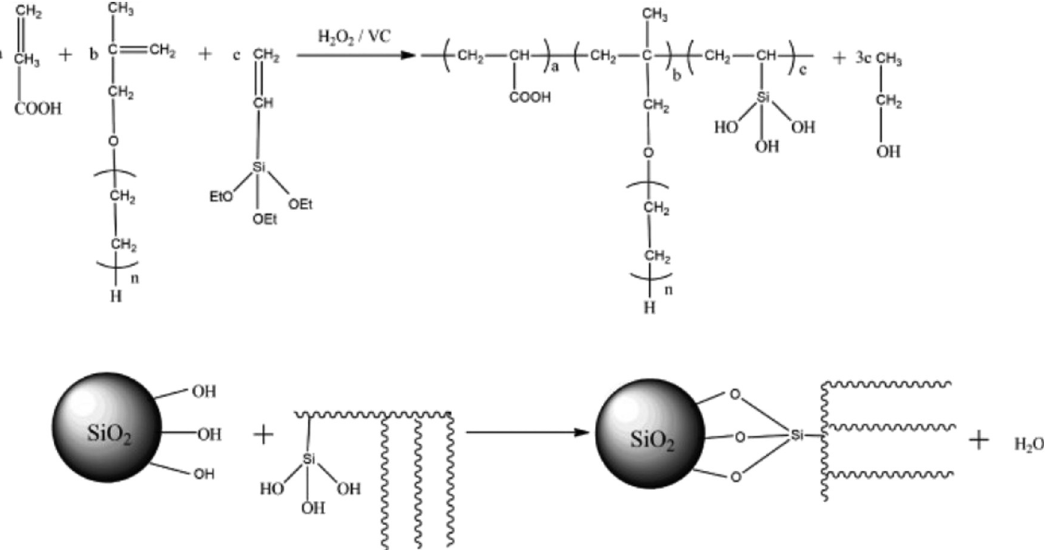
Figure 9: Schematic representation for ideal synthesis of SiO 2 @PCE [ 94 ] .